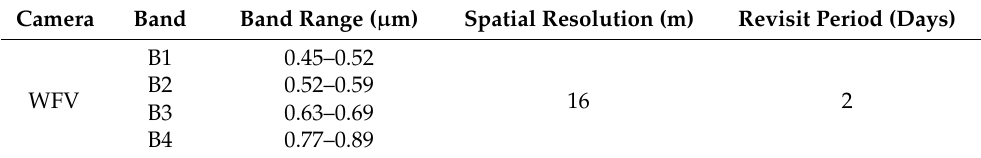
Table 2. Parameters of GF-1